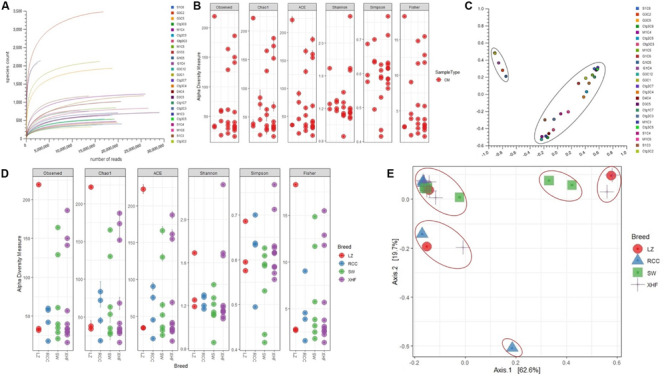
Bovine clinical mastitis (CM) milk microbiome diversity. (A) Rarefaction curves showing the influence of sequencing depth (number of reads per sample, x-axis) on species richness (y-axis) in CM milk samples. The rarefaction curves representing the number of species per sample indicated that the sequencing depth was sufficient enough to fully capture the microbial diversity as existed. (B) Alpha diversity measured using the observed species, Chao 1, ACE and Shannon diversity indices through PathoScope (PS) analysis. The observed species richness (PObserved = 0.511), Chao1 (PChao1 = 0.081), ACE (PACE = 0.121), Shannon (PShannon = 0.401), Simpson (PSimpson = 0.011) and Fisher (PFisher = 0.014) diversity analyses revealed that microbiome diversity did not vary among the CM samples. (C) Beta diversity (Principal coordinate analysis; PCoA) measured on the Bray-Curtis distance method using MG-RAST tool for CM causing microbial communities (genus-level) shows that most of the CM samples clustered together (black circle), indicating no significant diversity differences. (D) Alpha diversity measured using species richness (PObserved = 0.011), Chao1 (PChao1 = 0.001), ACE (PACE = 0.021), Shannon (PShannon = 0.001), Simpson (PSimpson = 0.009) and Fisher (PFisher = 0.023) diversity matrices on PS data showed significant differences (Kruskal–Wallis test, P = 0.002) in microbial diversity across the four cow breeds (Local Zebu cows, LZ; Red Chattogram cows, RCC; Sahiwal, SW; Holstein Friesian cross, XHF). (E) PCoA plot based on weighted-UniFrac distance method at strain-level microbiome signature of four breeds of cows reveals that the CM samples appear more distantly (red circles) indicating significant group differences (P = 0.001). These differences in the microbiome signature associated with CM across the four breeds could be explained by a large percentage of variation in the first (62.6%) and second (19.7%) axes.